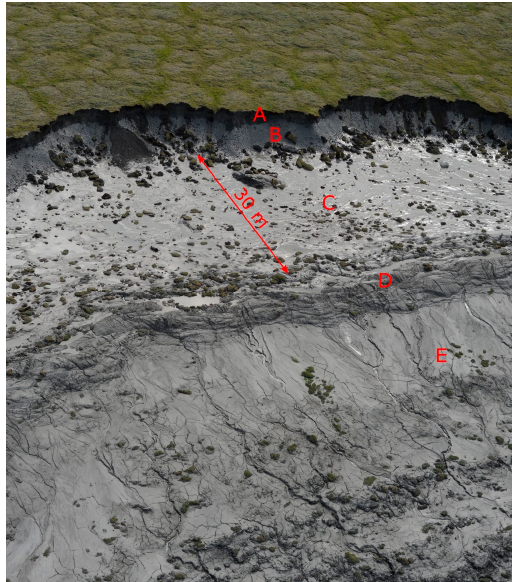
Figure 4. Oblique aerial photograph of the main scarp and adjacent slump floor of slump NOAT070 on 19 July 2011. The main scarp was 4 to 5 m high and exposed about 1.5 m of dark glacial till ( A ) over light gray glacial ice ( B ). The shiny zone below the scarp ( C ) was viscous, water-saturated mud, while the dull-colored material ( E ) was compact sediment that would support a person’s weight. The main scarp position at the previous visit (22 June 2010) was just below the small ridge ( D ) that separates the liquid and solid zones of the floor.